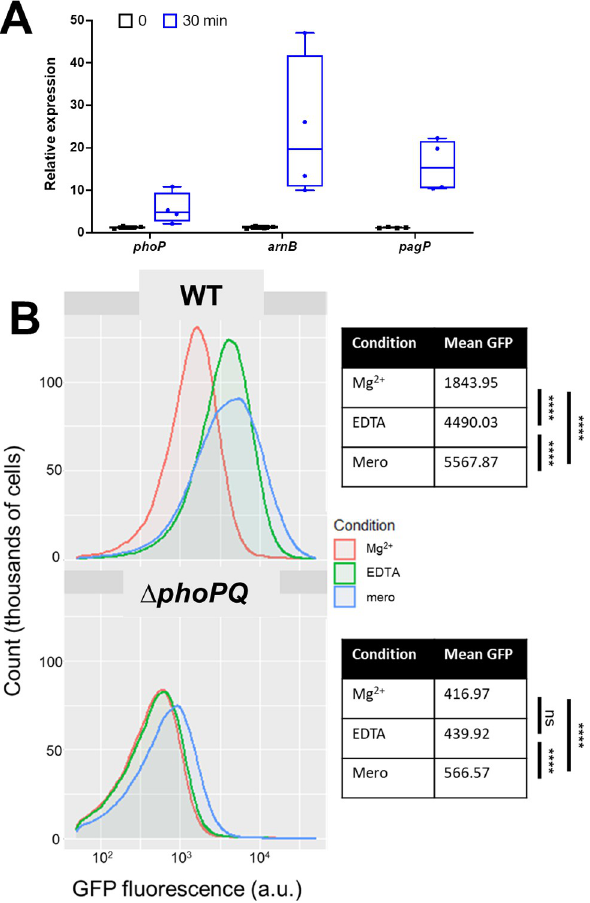
Fig 3. Expression of arn B in response to meropenem treatment is dependent on PhoPQ. (A) Relative expression reverse-transcription quantitative PCR (qRT-PCR) of PhoPQ regulon transcripts after meropenem exposure. Each experiment was independently replicated three times (individual data points of the three experiments are reported here). (B) Strains carrying transcriptional P arnB : msGFP fusions were exposed to indicated conditions and analyzed on a C6 Accuri flow cytometer. Statistical difference between populations was determined with a one-way ANOVA followed by Tukey’s correction for multiple comparisons (ns, not significant; ���� , p � 0.0001).